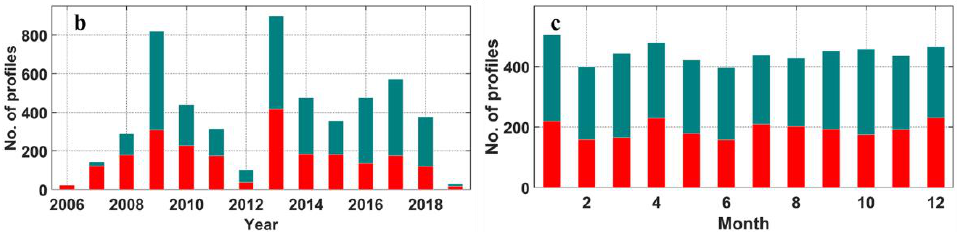
Figure 2. ( a ) Station map of Argo float profile data (grey dots) in the northern South China Sea (NSCS). Background color indicates bottom topography. ( b ) Temporal distribution of the count of Argo profile data in each year. Green bars denote the total dataset, and red bars, only the data north of 18° N. ( c ) Temporal distribution of the count of Argo profile data in each month. Green bars denote the total dataset, and red bars, only the data north of 18° N.